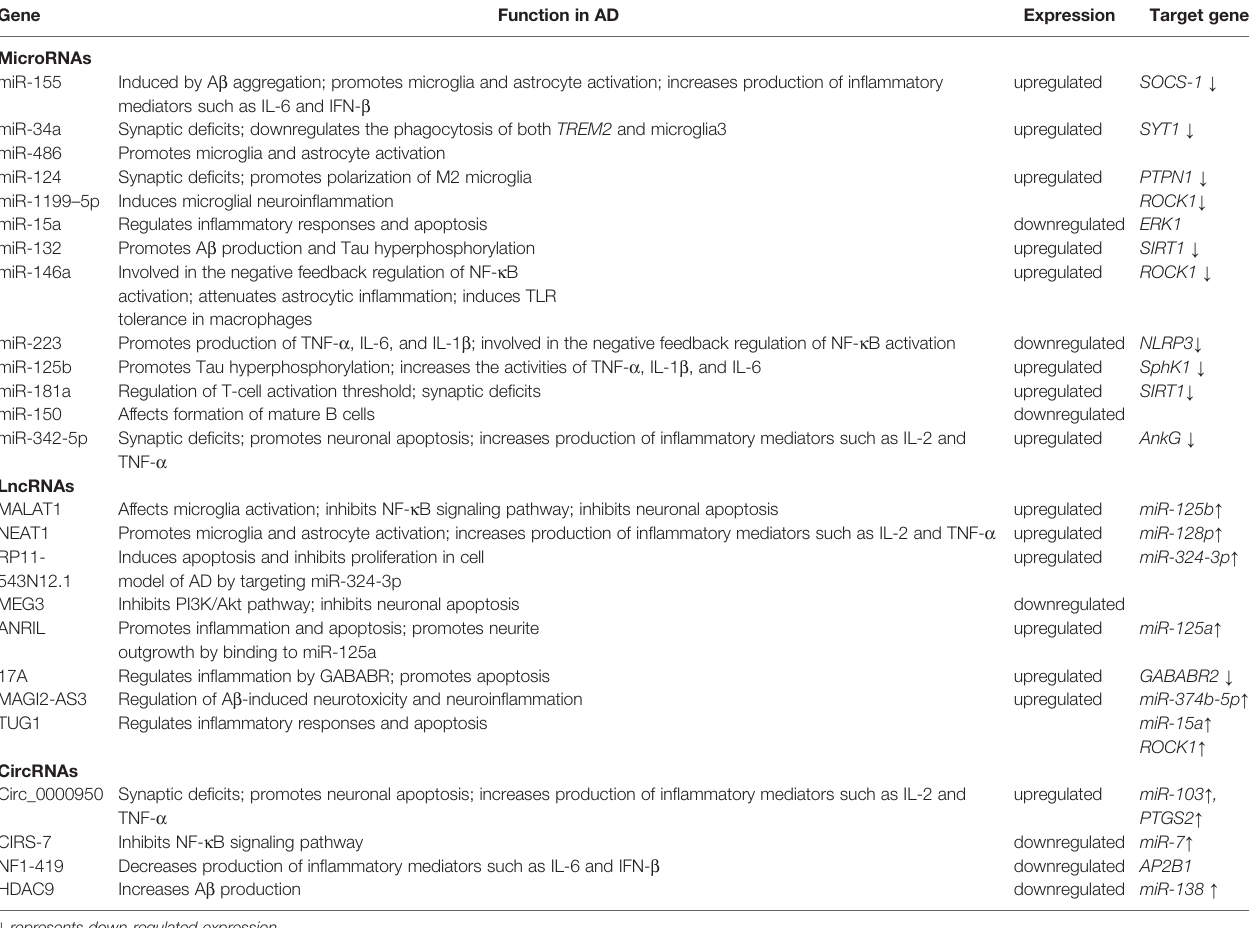
TABLE 1 | The main in fl ammatory ncRNAs for AD. Gene